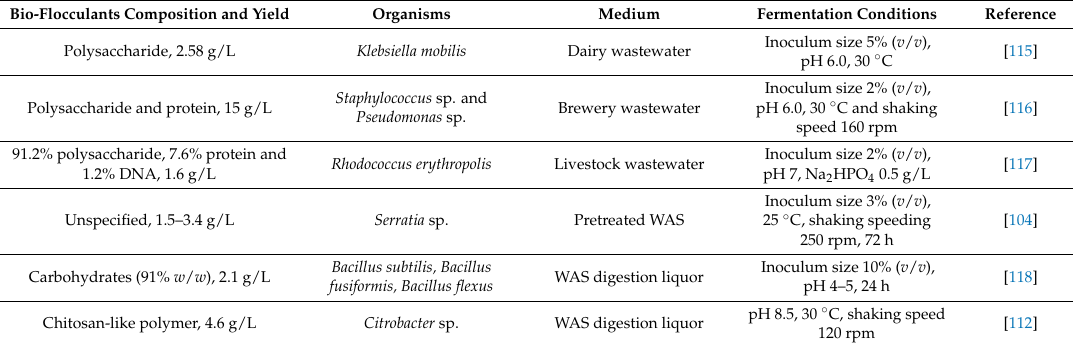
Table 6. Reported experimental (laboratory-scale) conditions for bio-flocculants production from WAS-derived